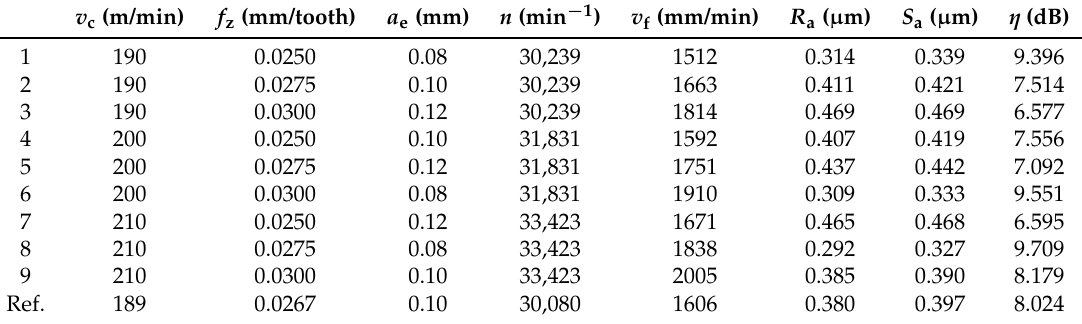
Table 11. Factors and their respective levels for ball end milling of vertical surfaces, R a provided additionally ( λ C = 0.25mm, λ S = 2.5µm).